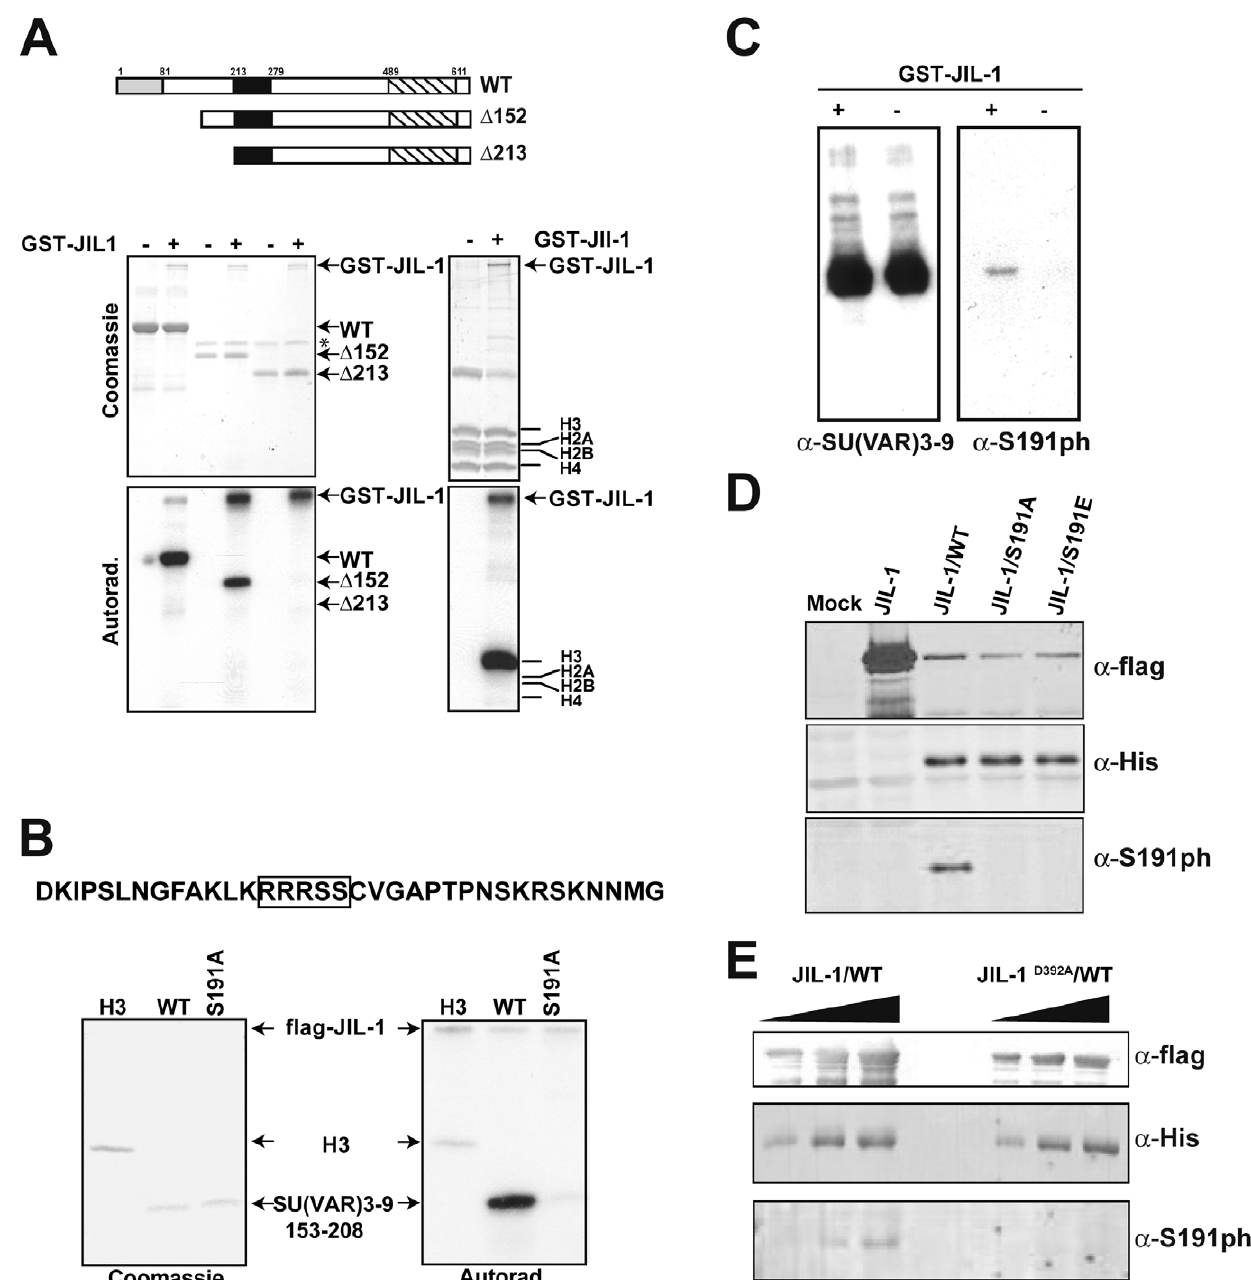
Figure 3. SU(VAR)3–9 is a target for phosphorylation by the chromosomal kinase JIL-1. ( A ) JIL-1 phosphorylates the N-terminus of SU(VAR)3–9 in vitro . top : schematic representation of the SU(VAR)3–9 constructs used for the in vitro kinase reaction (WT= SU(VAR)3–9; D 152/ D 213= N-terminal deletions of 152 or 213 amino acids respectively). Bottom left : in vitro kinase reactions with recombinant and purified GST-JIL-1 (expressed in SF9 cells using a baculoviral system) and bacterial expressed, affinity purified his-SU(VAR)3–9. Bottom right : As a control reaction Drosophila histones were analyzed in a kinase assay ( + / 2 GST-JIL-1). The band labeled with an asterisk corresponds to BSA, which was included in the purification procedure. ( B ) The serine 191 of SU(VAR)3–9 (S191) is the major phosphorylation site. top : Amino acid sequence of the putative phosphorylation domain as determined by the kinase assays in panel ( A ). The boxed sequence motif indicates a homology to a cAMP kinase consensus site. bottom : in vitro kinase assay with recombinant and purified flag-JIL-1 and bacterial expressed, affinity purified GST-SU(VAR)3–9 fusion proteins containing the putative phosphorylation domain (PD: aa 153–208) or a mutation of S191 to A. As a control reaction recombinant Drosophila histone H3 was assayed in comparison. ( C ) Specificity of the anti -SU(VAR)3–9-phospho antibody ( a -S191ph). Recombinant his-SU(VAR)3–9 was subjected to an in vitro kinase assay with or without GST-JIL-1 ( + / 2 ). After stopping the reaction with SDS-loading buffer, the reactions were separated by SDS-PAGE followed by Western blotting using a -S191ph and an antibody against SU(VAR)3–9, respectively. ( D ) SU(VAR)3–9 WT but not S191A mutant proteins can be phosphorylated by JIL-1. ( E ) An inactive mutant of JIL-1 (JIL-1 D392A ) cannot phosphorylate SU(VAR)3–9. SF9 infected with increasing amounts of the indicated viruses (JIL-1= flag JIL-1; JIL-1 D392A = catalytically inactive form of flagJIL-1 WT = hisSU(VAR)3–9 wild type protein).